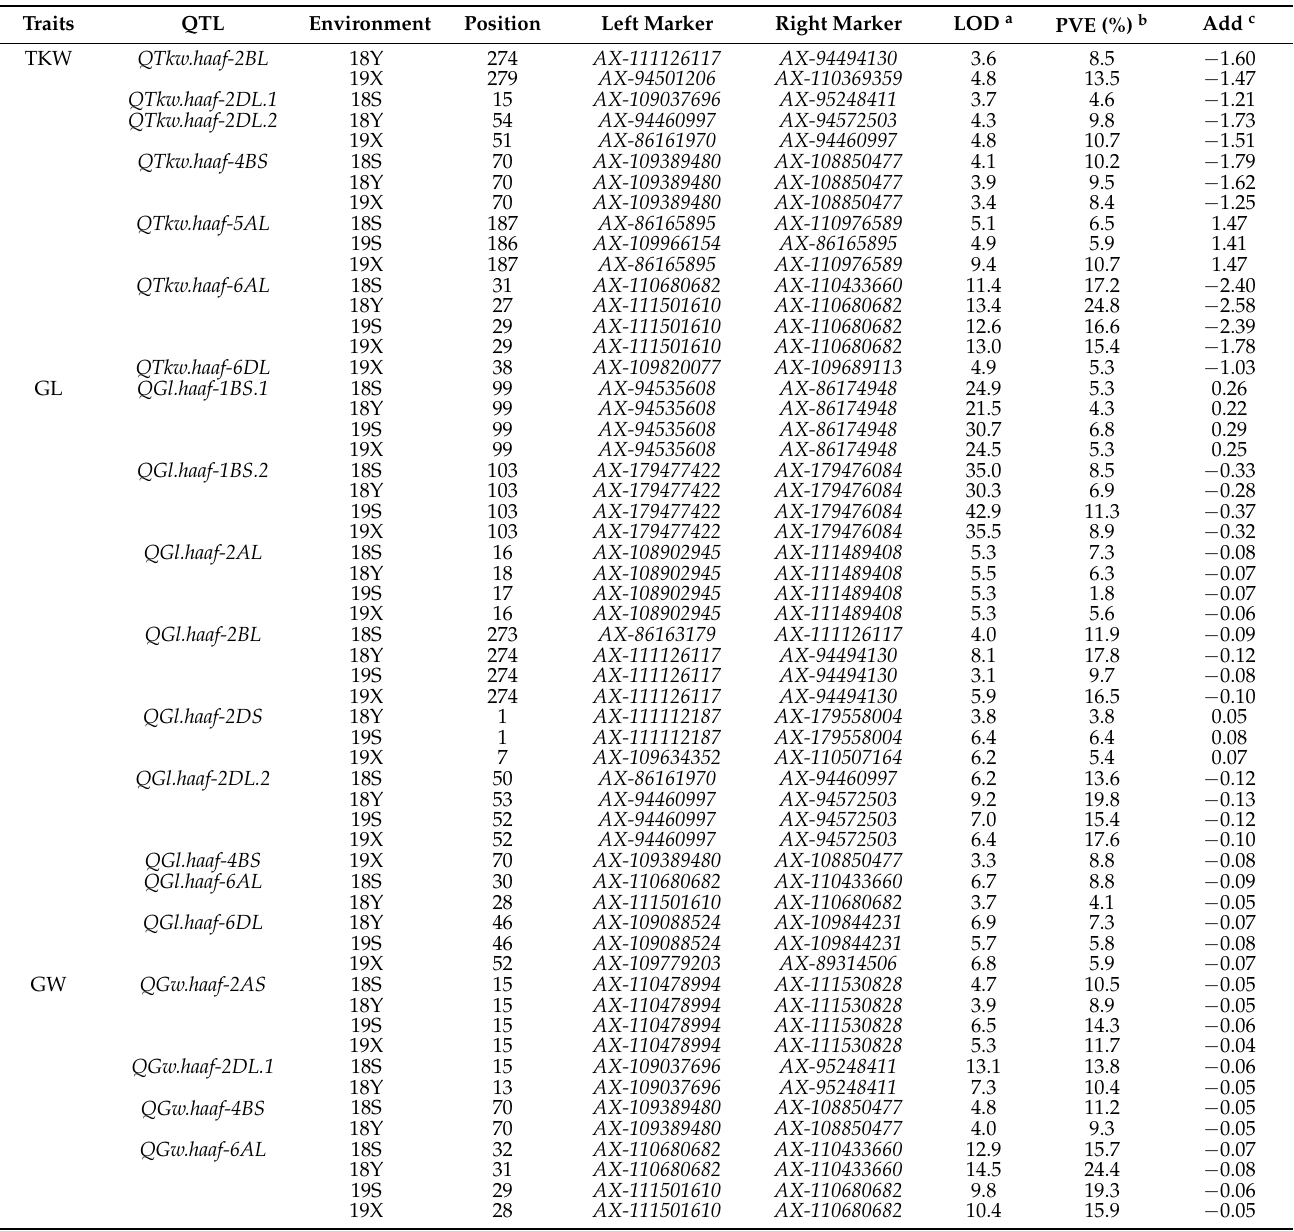
Table 4. Stable QTLs for thousand kernel weight (TKW), grain length (GL) and grain width (GW) in the F 6 recombinant inbred lines (RILs) population derived from a cross of HN5290 × 06Dn23 over all tested environments by using Inclusive Composite Interval Mapping